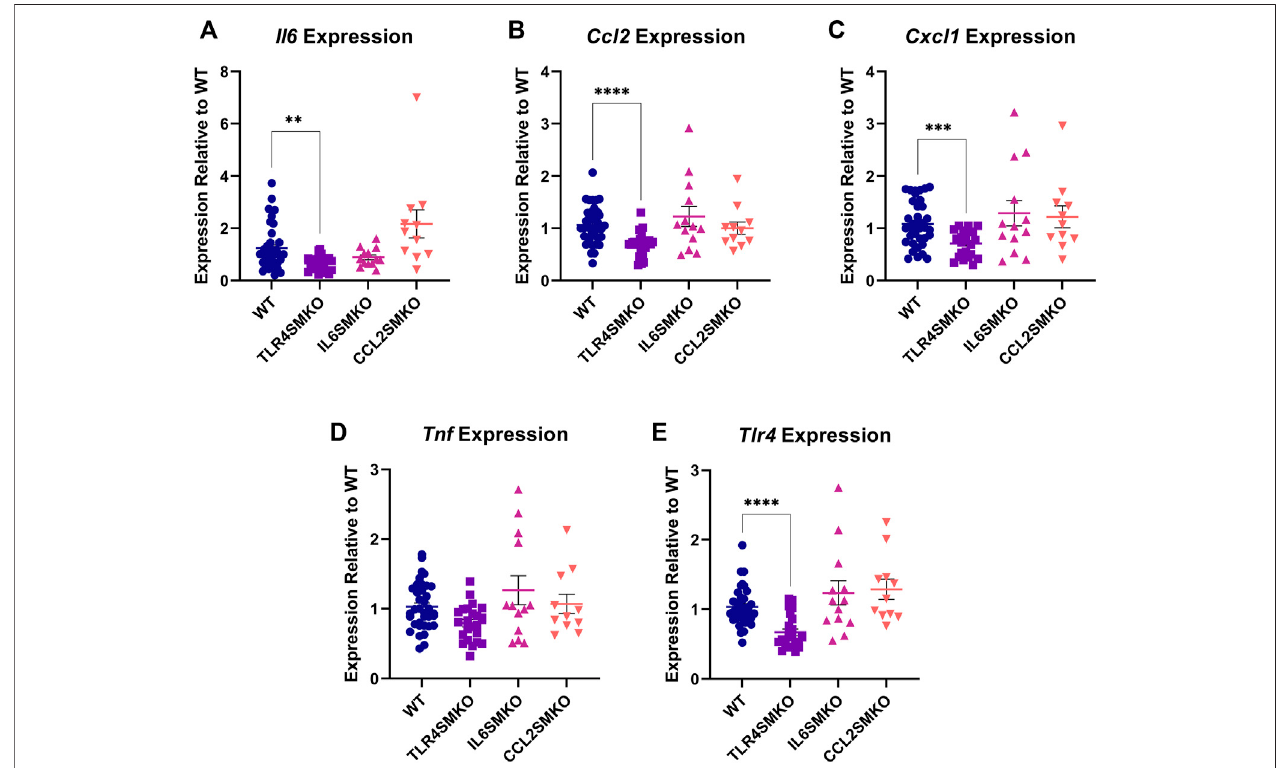
FIGURE 2 | Skeletal muscle cytokine expression 3 h after IV LPS. Gastrocnemius muscle Il6 (A) , Ccl2 (B) , Cxcl1 (C) , and Tnf (D) , as well as Tlr4 (E) , from myocyte speci fi c conditional knockouts for TLR4 (TLR4SMKO, n = 23), IL-6 (IL6SMKO, n = 13), CCL2 (CCL2SMKO, n = 11), or littermate controls (WT, n = 39). Values were analyzed using the 2 − ΔΔ Ct method relative to WT and compared using a one-way ANOVA with Dunnett ’ s multiple comparison test. p < 0.01 **, p < 0.001 ***.